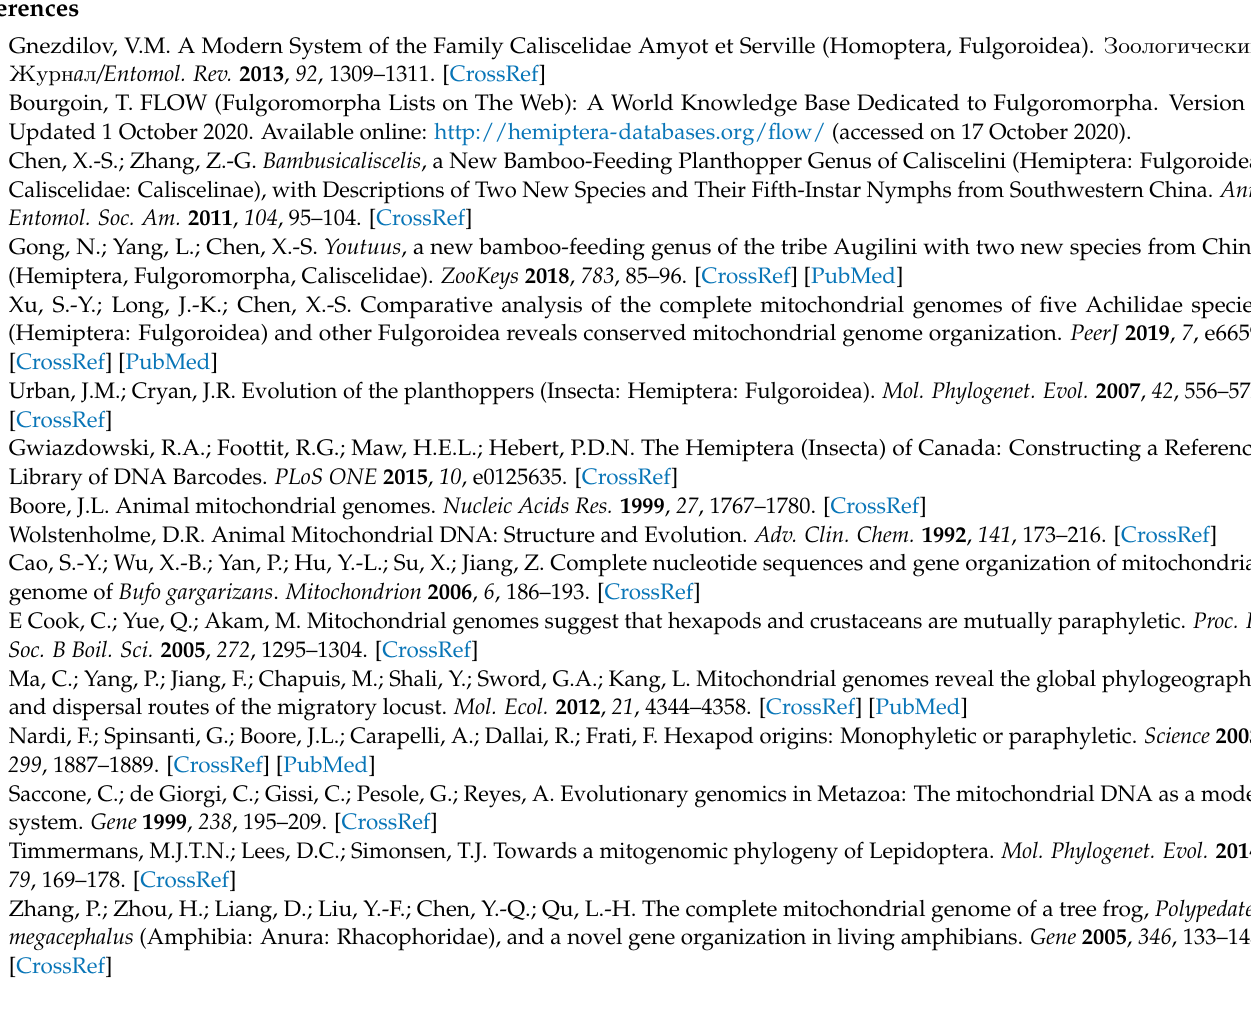
Table S2. The partition schemes and best substitution models used in the phylogenetic analysis; Table S3. Codon number and relative synonymous codon usage (RSCU) in the four mitochondrial